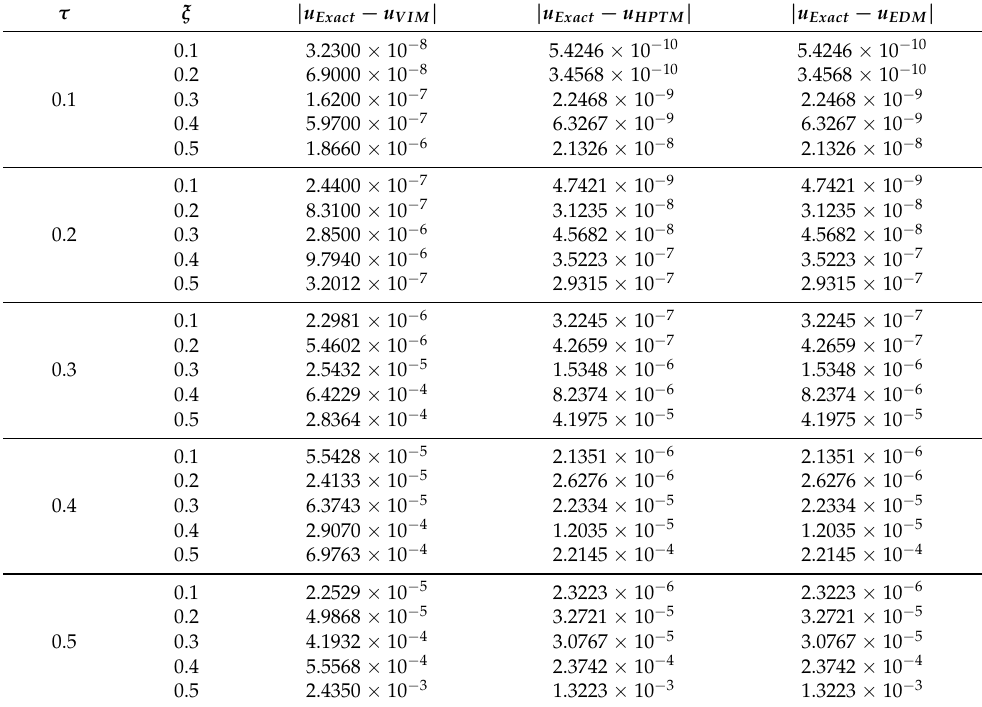
Table 2. Comparative study between varational iteration method (VIM) [34], NDM CF and NDM ABC for the numerical result u ( ξ , ζ , τ ) of Example 1 at Re = 100, ζ = 1, α = 1, and β = 1 for l =